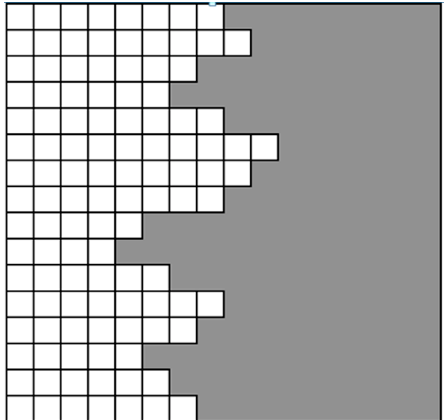
Figure 5. The Kossel model assumes attachment of solid on existing solid only i.e., it does not allow for any overhang. Using multiple layers it describes a stepwise transition from 100% solid (the 4 left layers) to 100% liquid (from layer 11 to the right). The projection of layers 5 to 10 yields a decreasing fraction of solid with increasing layer